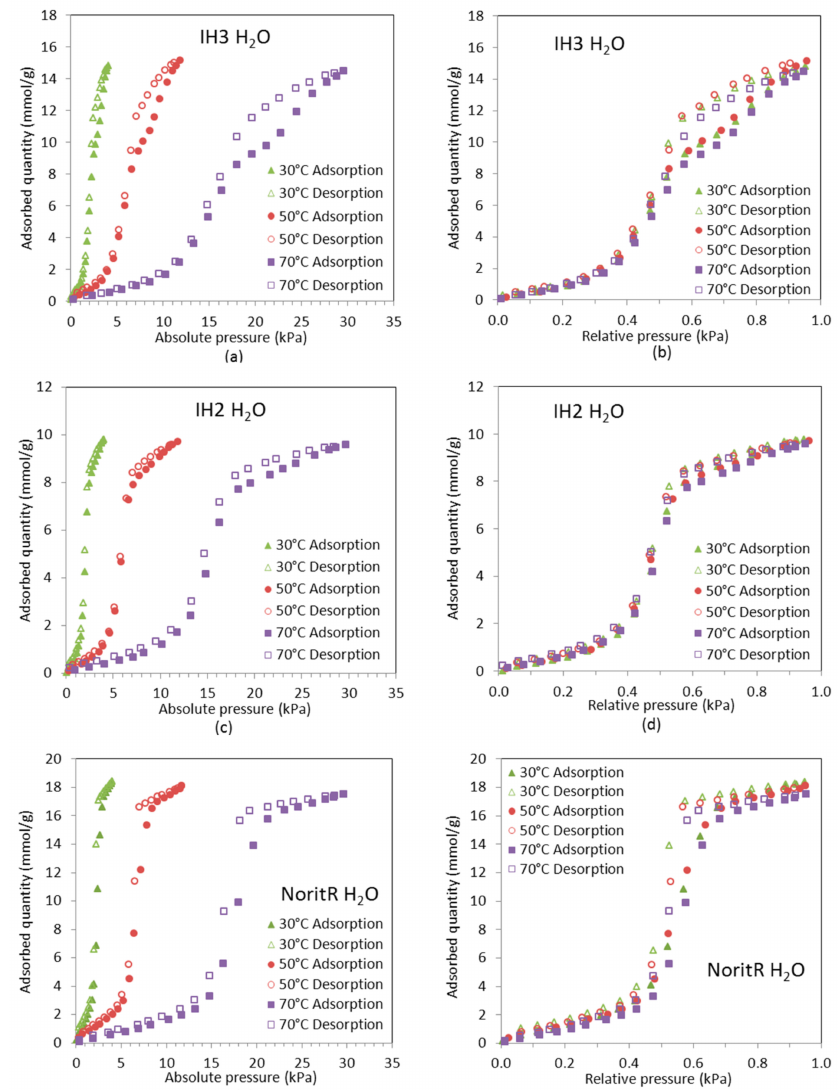
Figure 3. Water vapor adsorption isotherms of the prepared carbons and the commercial Norit R2030 at 30, 50 and 70 ◦ C up to the corresponding saturation pressure (full symbols correspond to the adsorption branch and empty symbols to the desorption branch): absolute pressure ( a , c , e ); and relative pressure ( b , d , f